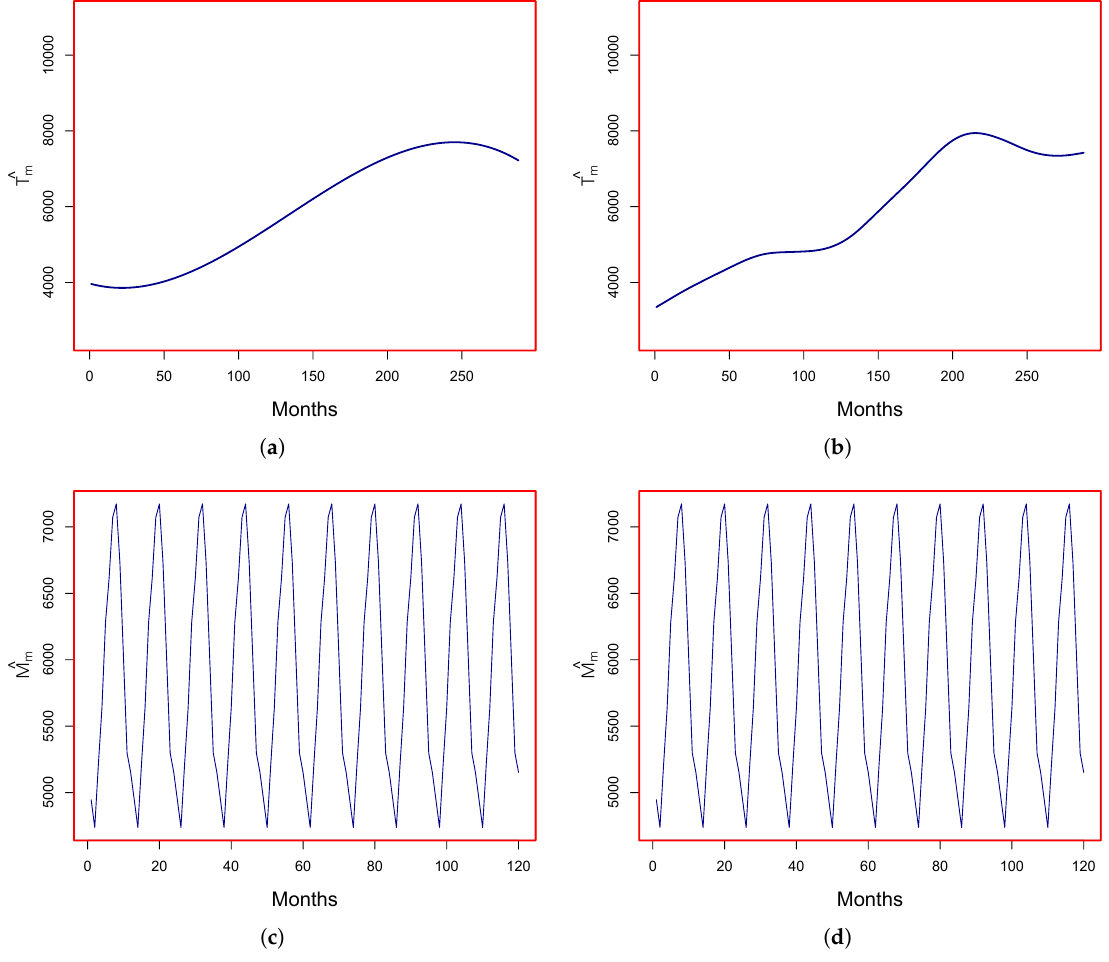
Figure 3. Components estimation: Trend (long-run) component ˆ T t estimated parametrically ( a ) and nonparametrically ( b ) and yearly periodicity component ˆ Y m estimated nonparametrically ( c ) and parametrically ( d